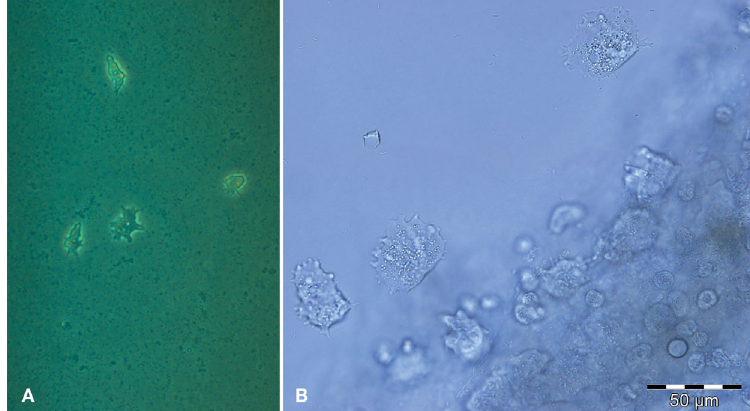
Fig. 1. (A) Neoparamoeba perurans visualised growing on MYA plates in culture. (B) A fresh gill mucus scrape with amoeba migrating from the